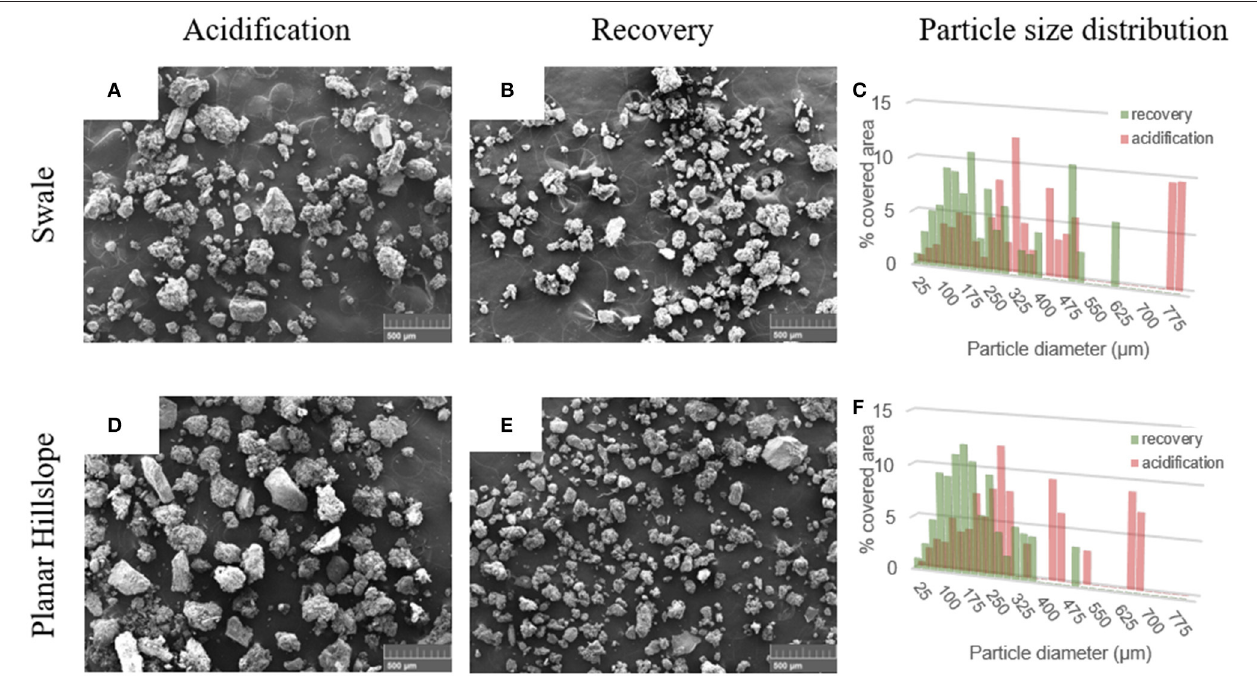
FIGURE 9 | Secondary electron scanning electron microscopy (SE SEM) images of soil aggregates taken from a swale (A,B) and planar hillslope (D,E) in Sleepers River Research Watershed (SRRW) after treatment with laboratory acidification (A,D) and recovery (B,E) solutions. Particle size distribution from image analyses for swale (C) and planar hillslope (F) aggregates are expressed in % covered area (i.e., the area that is covered by particles that belong to a given size